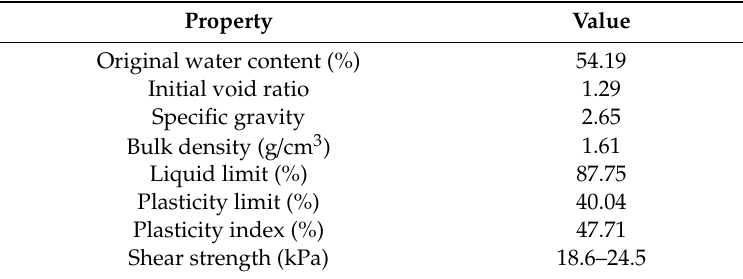
Figure 1. Four components for preparation of expanded polystyrene (EPS)-cement lightweight clays. Table 1. Properties of Singapore marine clay.